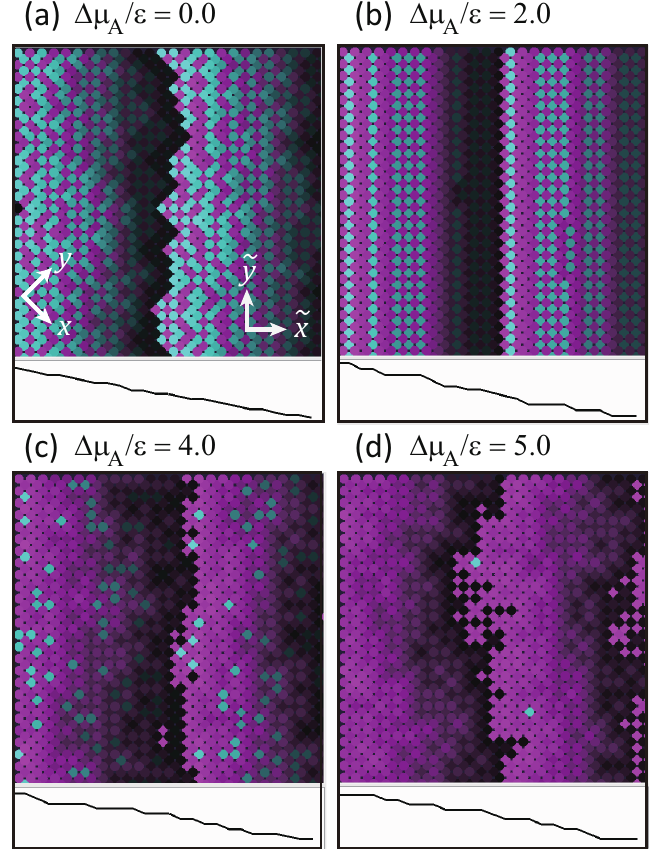
Figure 2. Top-down (top panel) and side (bottom panel) views of the surface for ( a ) ∆ µ A / (cid:101) = 0, ( b ) ∆ µ A / (cid:101) = 2.0, ( c ) ∆ µ A / (cid:101) = 4.0, and ( d ) ∆ µ A / (cid:101) = 5.0. Purple circles represent A atoms and blue circles represent B atoms. The surface height is represented by brightness (10 gradations). Higher brightness indicates a higher terrace. Because the number of steps exceeds 10, the darkest terrace is next to the √ √ brightest terrace. k B T / (cid:101) = 0.2. N step = 18. Size: 24 2 × 24 2. 4 × 10 8 Monte Carlo steps (MCS)/site. ∆ µ = − ∆ µ B A